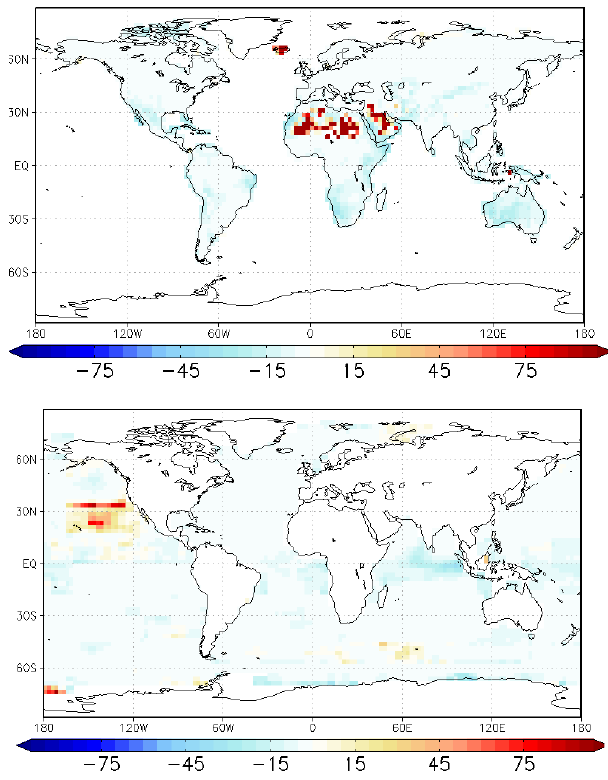
Fig. A2. Relative error in percent between RMS error for temporal variability of original fields and RMS error for temporal variabil- ity of fields restored with EOFs for two kinds of sources. (top – biosphere, bottom –